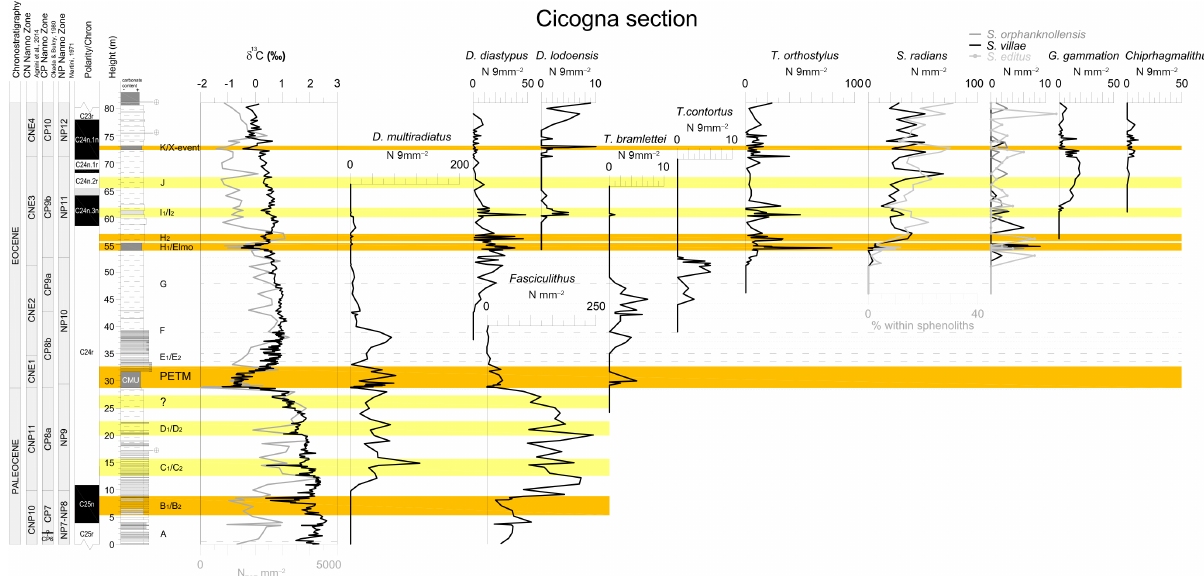
Figure 9. Relative (%) and semi-quantitative (Nmm − 2 ) abundances of selected, mainly early Eocene, calcareous nannofossil taxa across the Cicogna section. Also shown are the lithostratigraphy, magnetostratigraphy, biostratigraphy and carbon isotope ( δ 13 C) stratigraphy at the Cicogna section (Fig. 4). Color bands and symbols are the same as in previous figures.